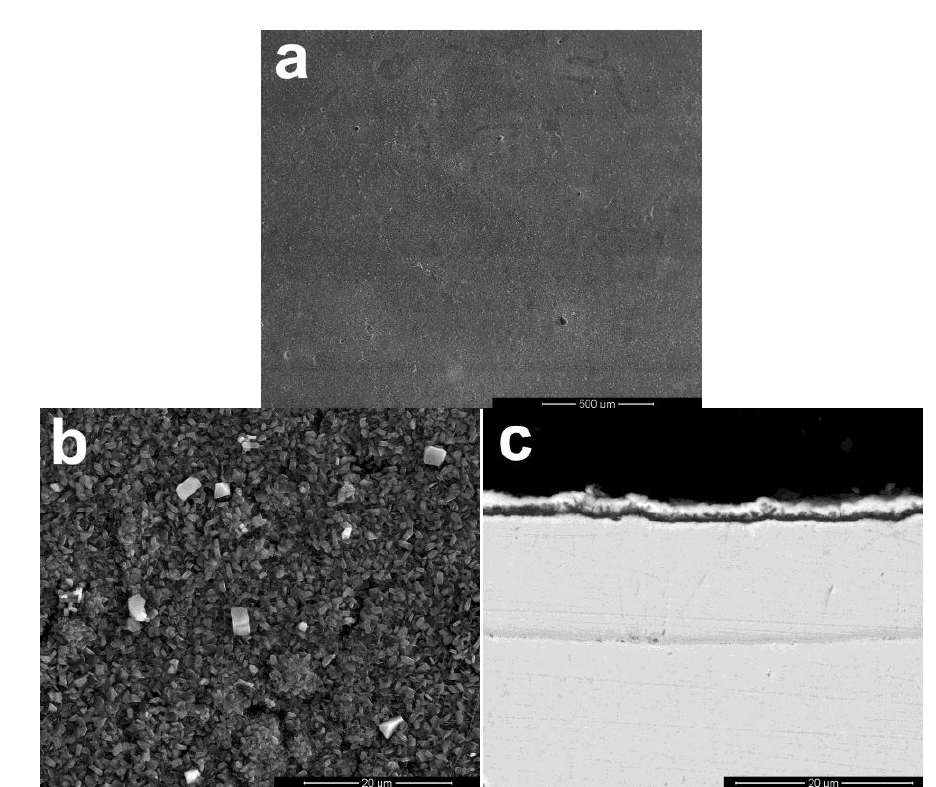
Figure 3. Scale morphology of coating K38-0.5Y after 60 h exposure at 900  C: ( a ) surface morphology, ( b ) magnified view of ( a ), ( c ) the cross-sectional morphology corresponding to ( b